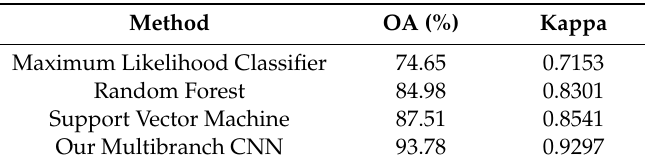
Table 8. Accuracy comparison with machine learning